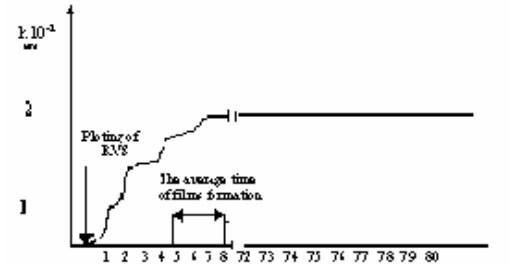
Fig 1. The dynamics of coating width’s growth in the contact zone